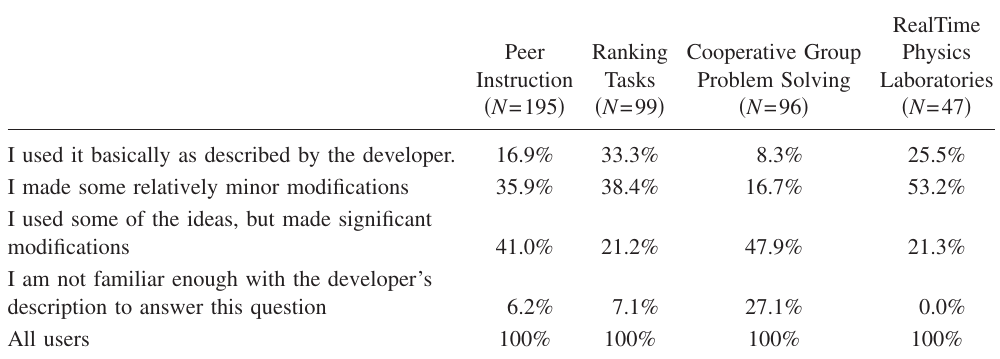
TABLE VIII. Extent of modification identified by self-reported users of all or part of each of four RBIS. The percentages listed are the percentage of users within each of the RBIS categories who answered the question.